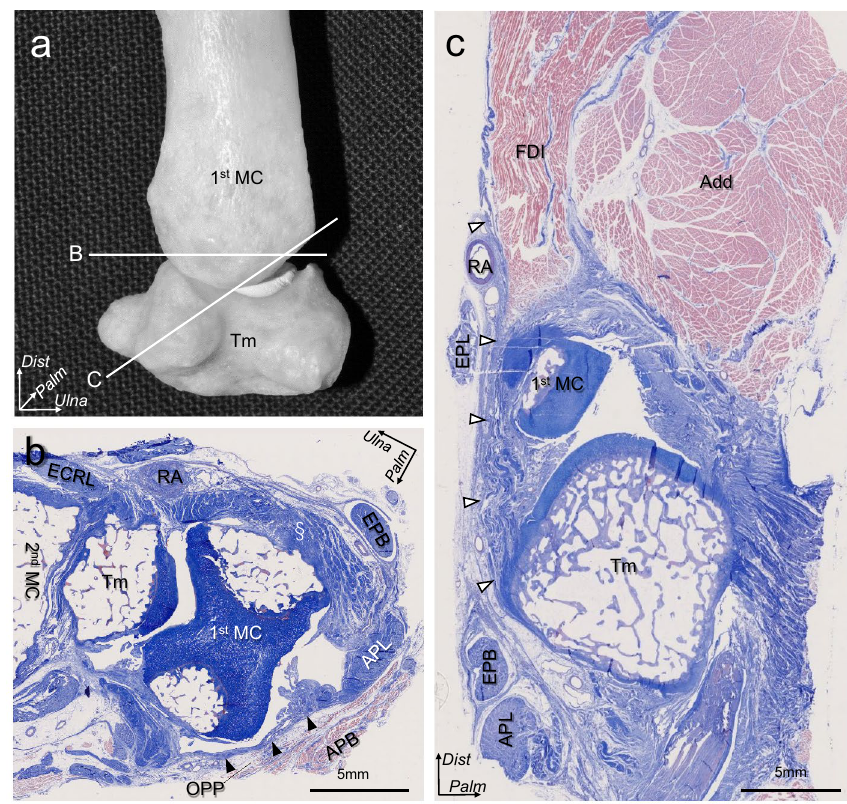
Figure 6. Histological analysis of the trapeziometacarpal joint. (a ) Bone image showing the dissection levels ( b ) and ( c ) as white lines. ( b ) Axial section at the trapeziometacarpal joint level. Dorsal and radial joint capsules are shown as section marks and black arrowheads, respectively. ( c ): oblique sagittal section parallel to the fibrous orientation of the first dorsal interosseous (FDI) aponeurosis. The FDI aponeuroses are continuous with the dorsal joint capsule (white arrowheads). 2nd MC, second metacarpal bone; ECRL, extensor carpi radialis longus; EPB, extensor pollicis brevis; APL, abductor pollicis longus; OPP, opponens pollicis; FPB, flexor pollicis brevis; RA, radial artery; Add, adductor pollicis; EPL, extensor pollicis longus; Ulna , ulnar; Palm , palmar; Dist , distal; Dors ,